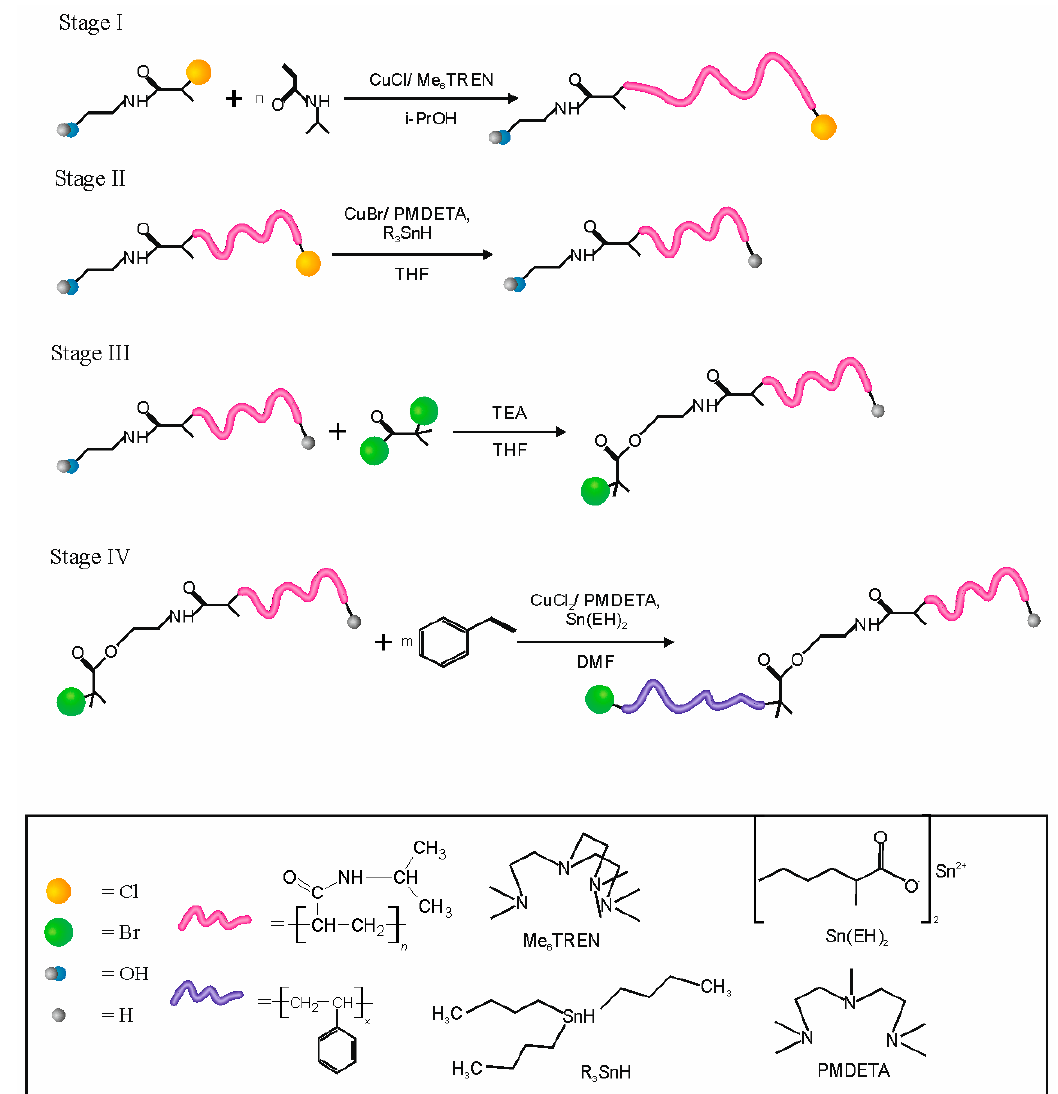
Figure 1. The scheme of the procedure leading to the preparation of PNIPAM-block-PS copolymers